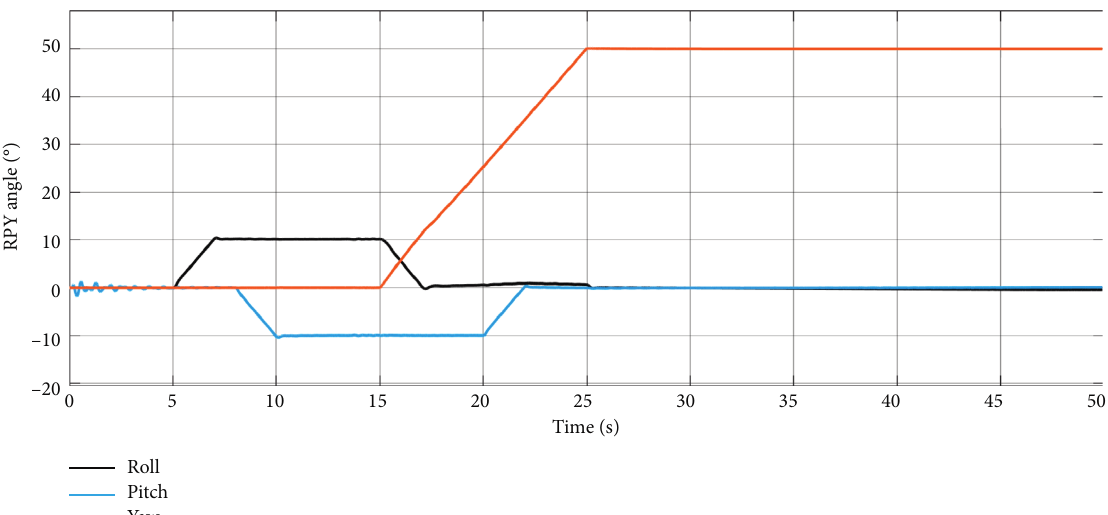
Figure 11: RPY output response curve of compound controller under interference.